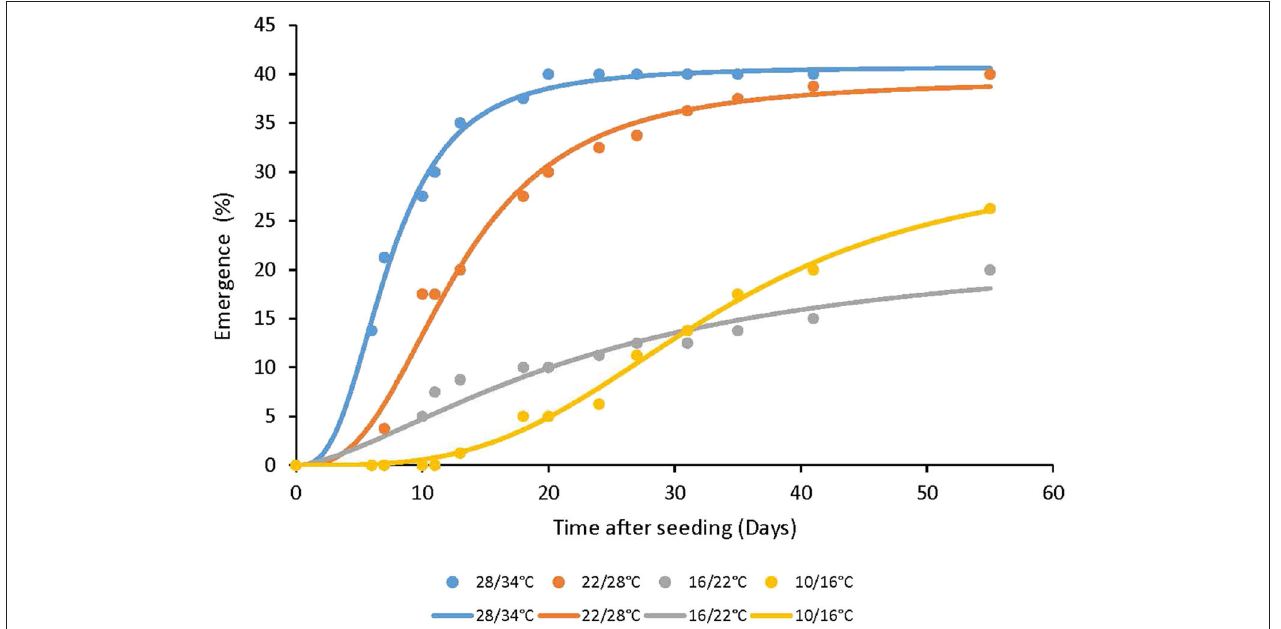
FIGURE 4 | The effect of temperature regimes on the seedling emergence rate of A. artemisiifolia. Seeds were placed on the soil surface (0cm seeding depth), 55 DAS. Three-parameter logistic nonlinear regressions between A. artemisiifolia emergence and time (days) were used. Parameters of the equations of four temperatures regimes are presented in Table 3 .